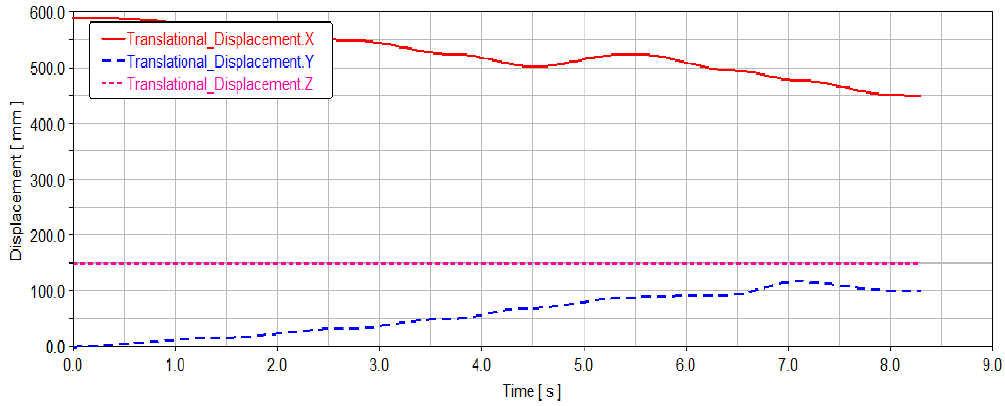
Figure 17. The displacement curve of the end-effector after the trajectory optimization.